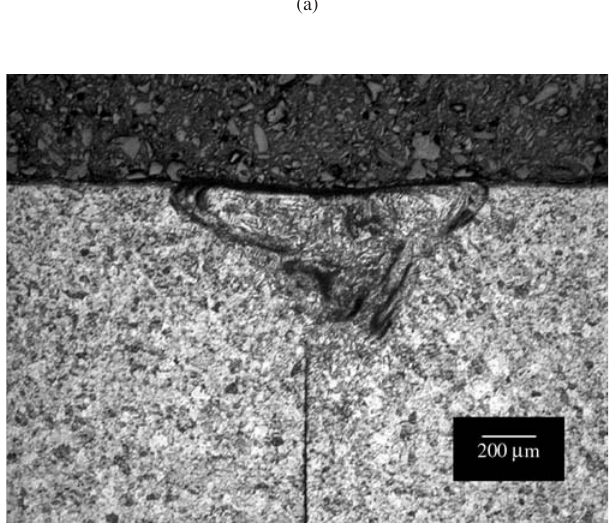
Figure 7. a) Transversal cut of the welding under a) normal; and b) optimized conditions. The energy is decreased by 30% in comparison with the conditions used to produce the Figure 3.